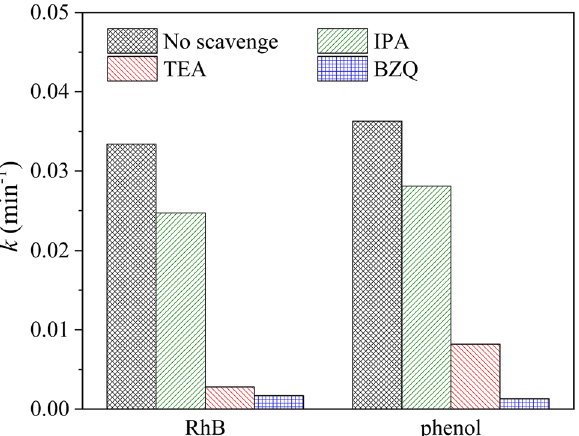
Figure 9. Effects of different scavengers on RhB and phenol photodegradation over the g-C 3 N 4 /Nb 2 O 5 heterojunction.